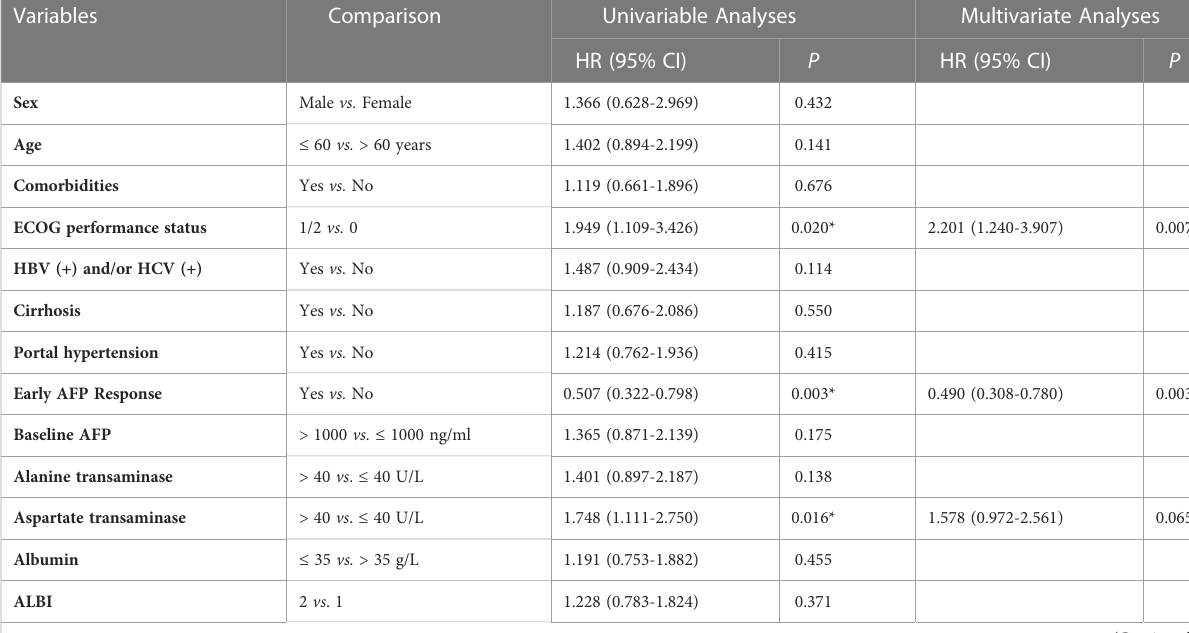
TABLE 3 Univariate and multivariate Cox regression analyses predicting overall survival. Variables Comparison Univariable Analyses Multivariate Analyses HR (95% CI) P HR (95% CI) P Male vs.